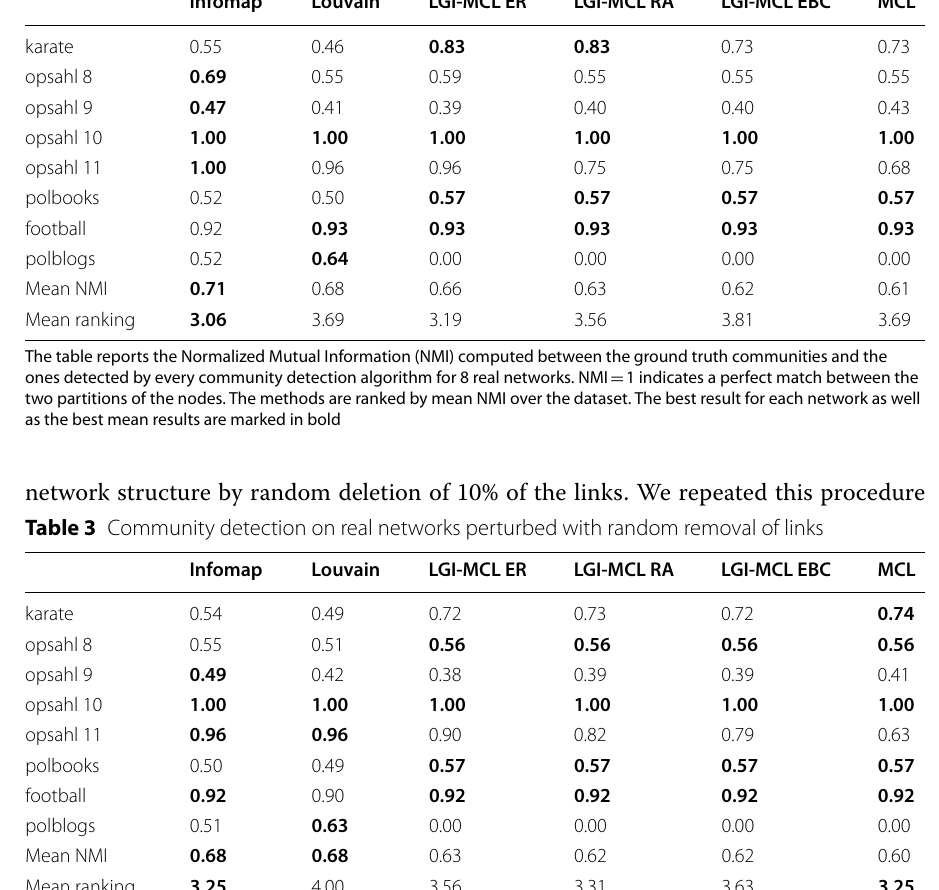
For each real network, 100 perturbed networks have been generated removing at random the 10% of links. The table reports the Normalized Mutual Information (NMI) computed between the ground‑truth communities and the ones